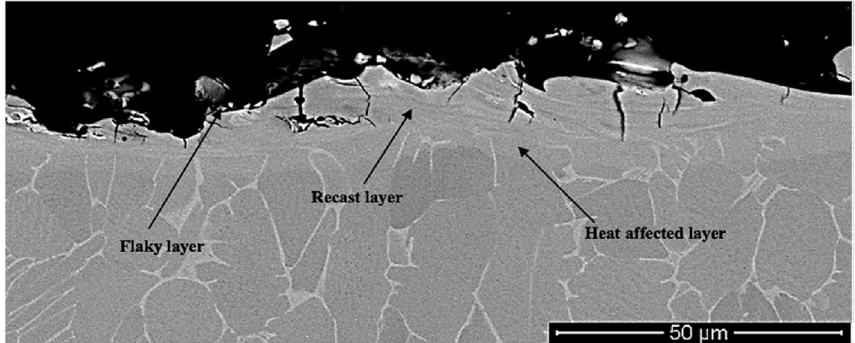
Fig. 3 Typical cross-sectional view of Ti6Al4V surface machined by wire EDM